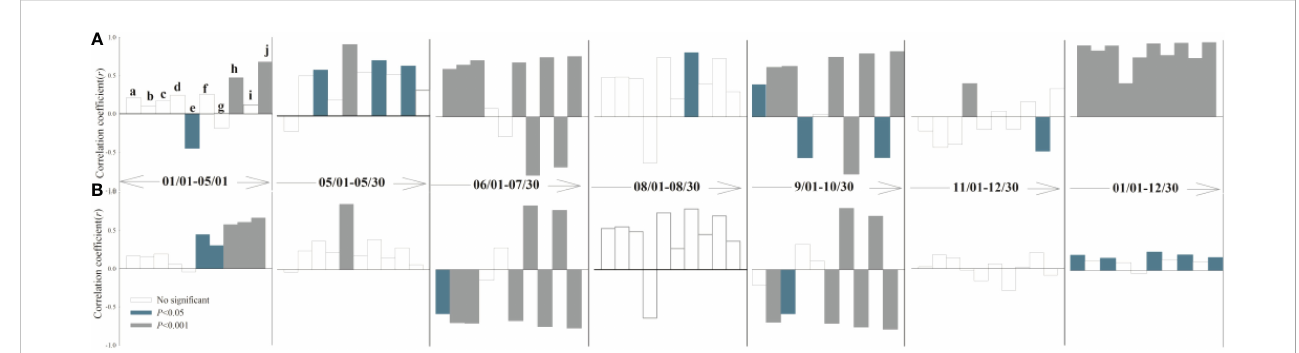
FIGURE 3 Partial correlation analysis between root length (A) , growth rate (B) and climatic factors (a: daily mean air temperature; b: daily minimum air temperature; c: daily maximum air temperature; d: daily precipitation; e: soil moisture -10 cm; f: soil temperature -10 cm; g: soil moisture -20 cm; h: soil temperature -20 cm; I: soil moisture -30 cm; j: soil temperature -30 cm). Correlation coef fi cient >0 denotes positive correlation, while correlation coef fi cient <0 denotes negative correlation.